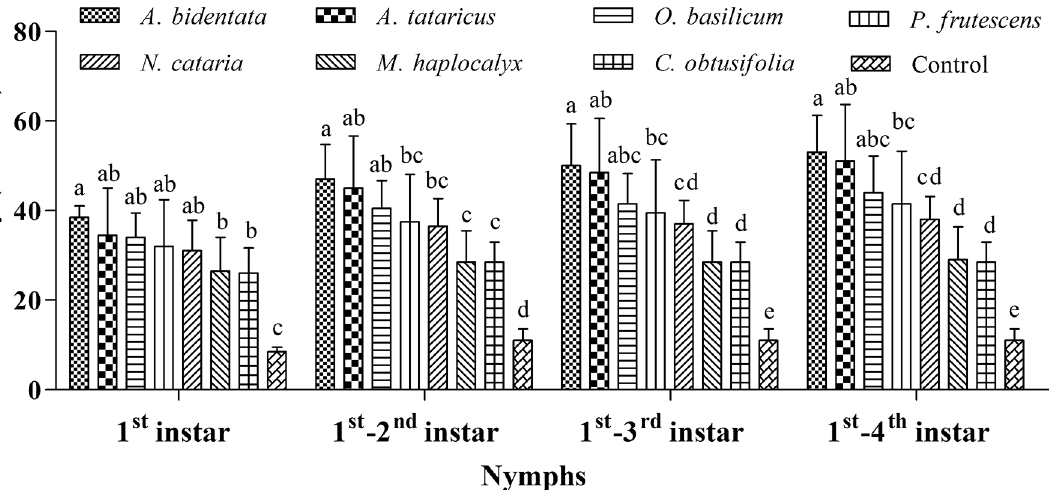
Fig 1. Mean mortality (% ± SE) of grape phylloxera eggs, on grapevine root treated with aqueous root extract of Chinese medicinal herbs. Within each diagram and instars, means followed by the same letters are not significantly different (Tukey ’ s HSD test, P > 0.05).